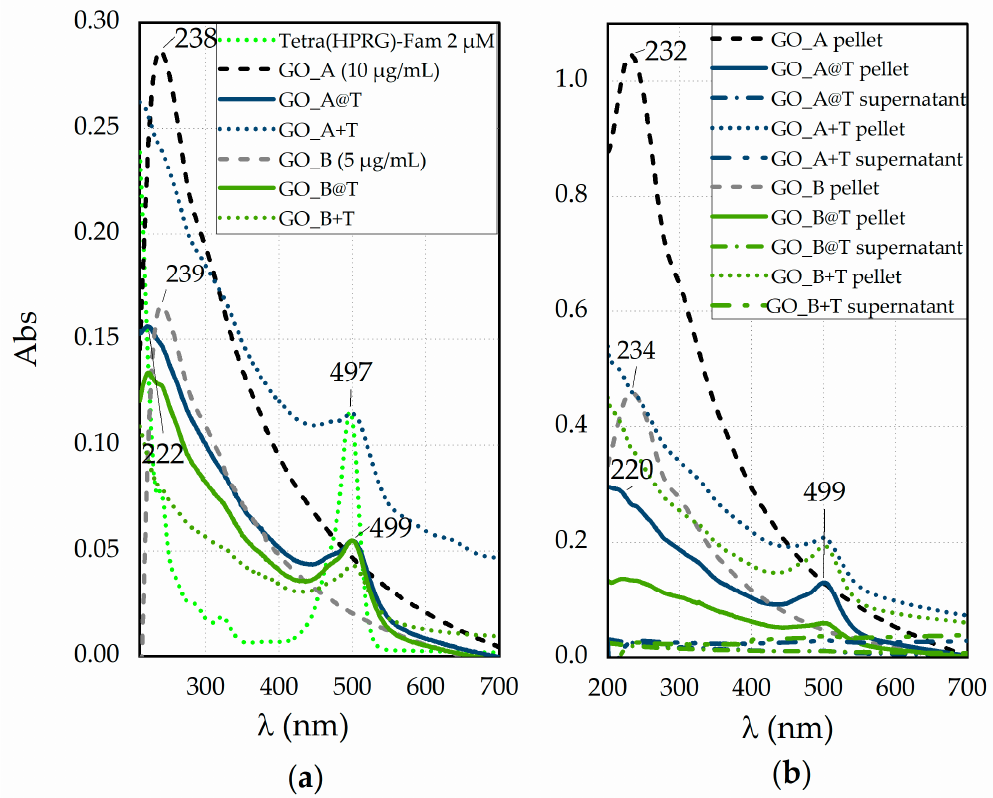
Figure 1. ( a ) UV-visible spectra in phosphate bu ff er saline solution (PBS, pH = 7.4) of GO_A and GO_B 100 × diluted dispersions, both before (dashed lines for GO_A, in black, and GO_B, in grey, respectively) and after 2 h of incubation with the peptide (solid line for GO_A@T, in dark green, and GO_B@T, in light green, respectively). The reference spectra of Tetra(HPRG)-Fam (green, 100 × diluted solution of that used for the incubation of GO_A and GO_B samples) and the mixtures immediately the mixing (GO_A + T, in dark green, and GO_B + T, in light green, respectively) are shown for comparison in dot line. ( b ) UV-visible spectra in PBS of the pellets for hybrid GO_A@T and GO_B@T samples (solid lines), the GO_A + T and GO_B + T mixtures (dot lines) and, for comparison, of bare GO_A and GO_B pellets (dashed lines) after two centrifugation (2700 RCF, 2 min, RT) and washing steps. The spectra of supernatants (dashed dot lines) of GO@T samples collected after the first washing step are included.